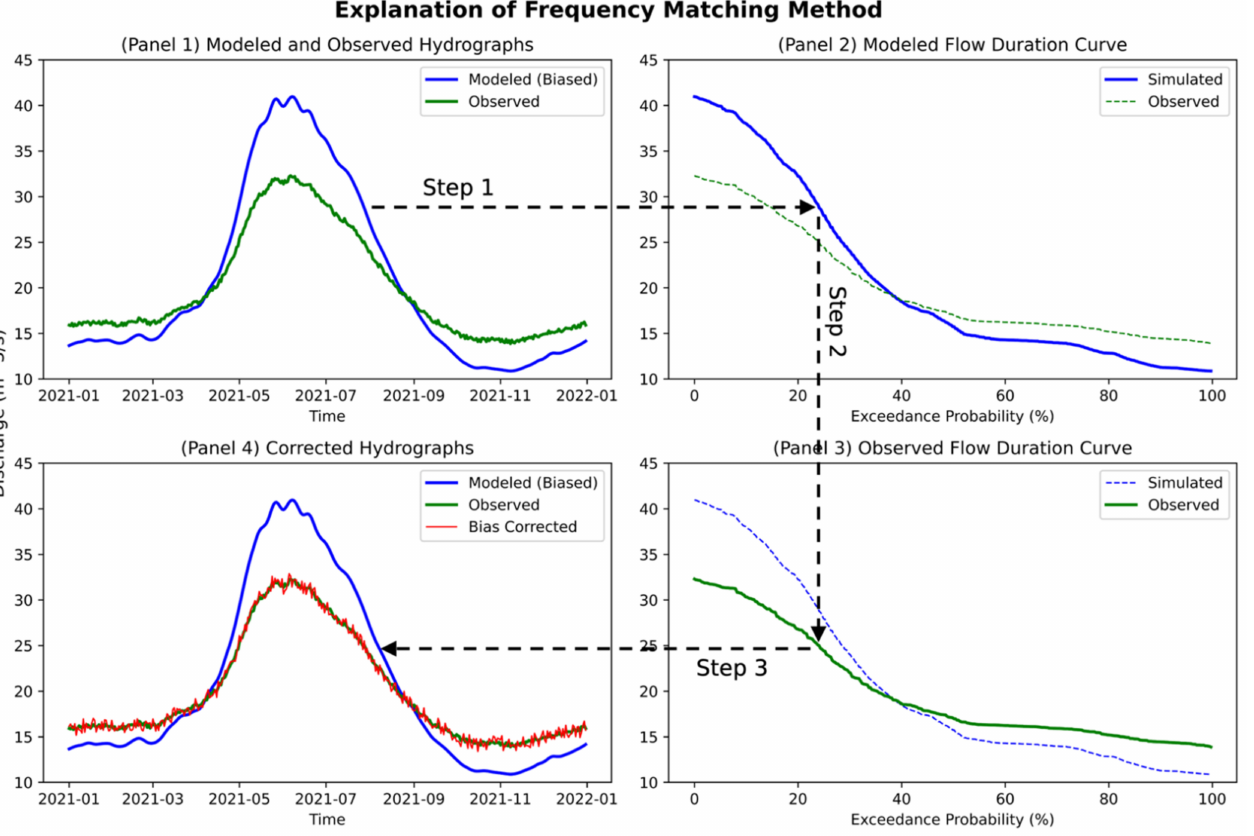
Figure 1. A process diagram of the frequency-matching approach for bias correction using simulated and observed flow duration curves to map biased simulations to observed